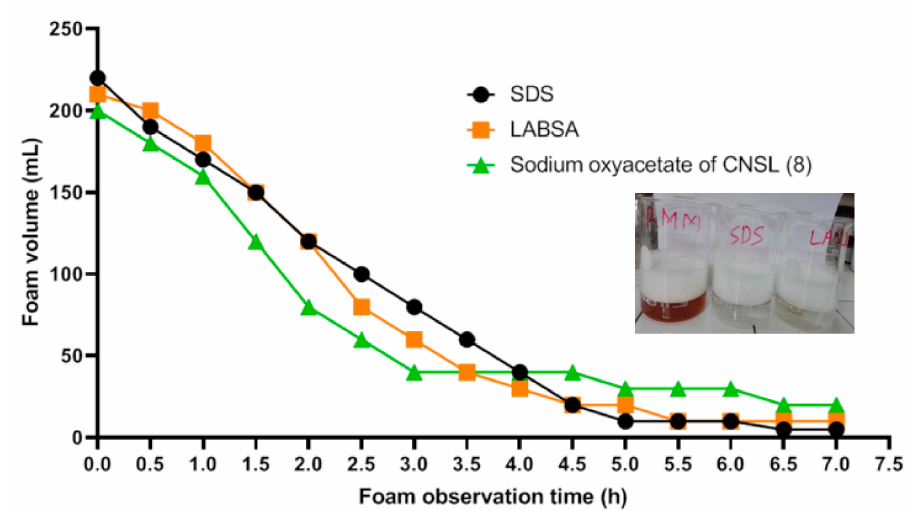
Figure 3. Comparison of the foaming powers of surfactants (sodium oxyacetate of CNSL ( 8 ), LABSA,